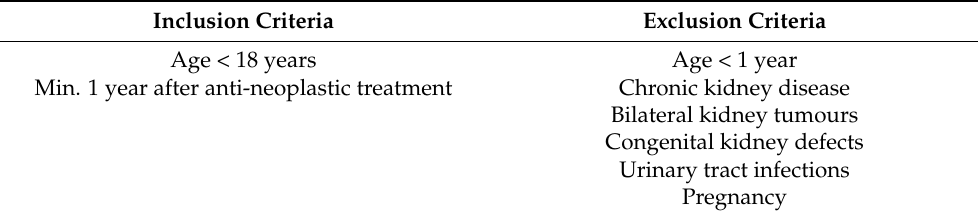
Table 1. The inclusion and exclusion criteria of the